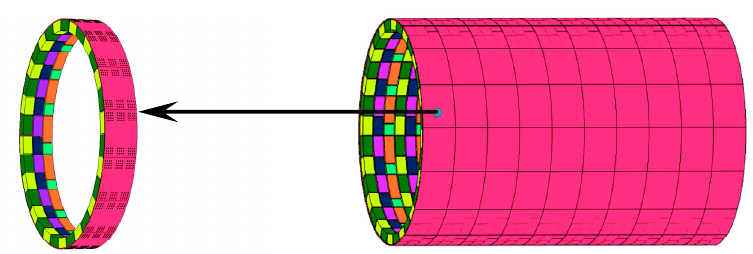
Figure 21. The cylindrical non-uniform acoustic absorber formed by the bent BAUs.